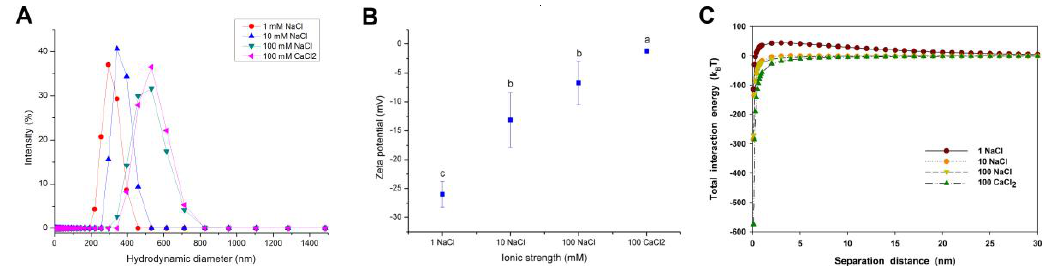
Figure 2. Size distribution ( A ); zeta potential ( B ); and calculated DLVO total interaction energy ( C ) of CuO NPs (100 mg/L) in the aqueous solution with different ionic strength (1, 10, and 100 mM NaCl) and ionic valance (Na + and Ca 2+ ) at a neutral pH. The values of zeta potential were given as mean ± SD of triplicate samples. Different letters in Figure 2B indicate significant differences among the treatment means ( p < 0.05).